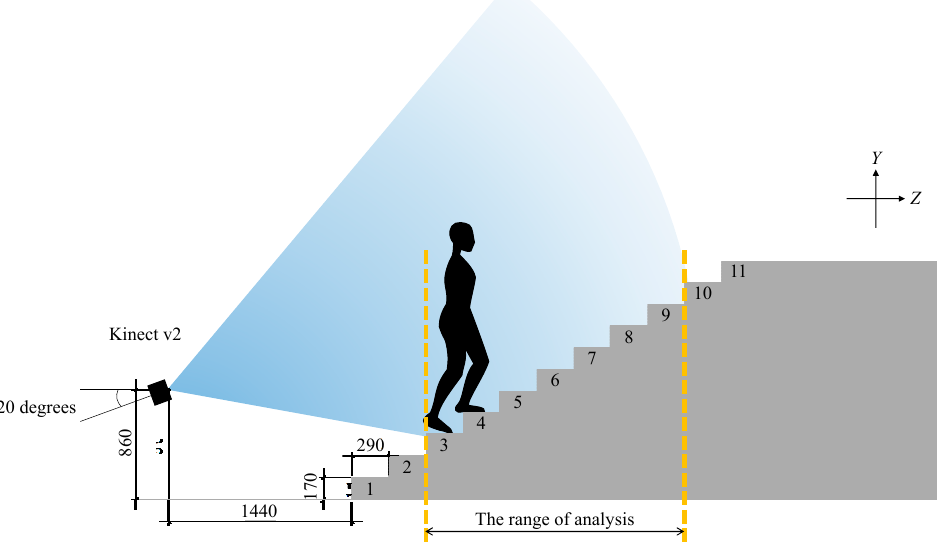
Figure 1. Experimental setup for stair climbing measurements using “IR-Locomotion” as a non- contact markerless system. We measured stairs climbing on an 11 steps staircase. The run length, riser height, and width were 290 mm, 170 mm, and 1350 mm, respectively. Kinect v2, a markerless RGB-D sensor, was set 1440 mm from the stairs at a height of 860 mm and 20 degrees tilted. Since the start and end of walking included acceleration and deceleration, namely a non-steady state, the knee joint trajectory of one step was extracted and analyzed from seven steps, excluding the first and the last two steps.